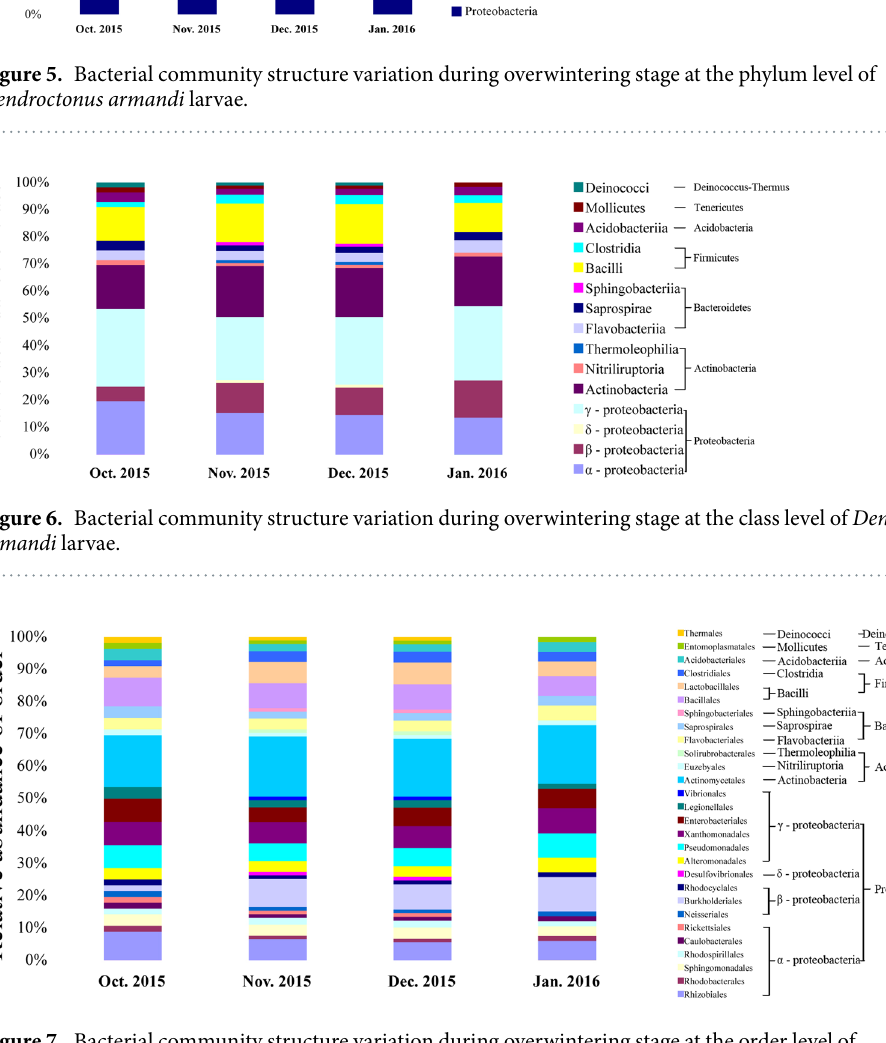
Figure 7. Bacterial community structure variation during overwintering stage at the order level of Dendroctonus armandi